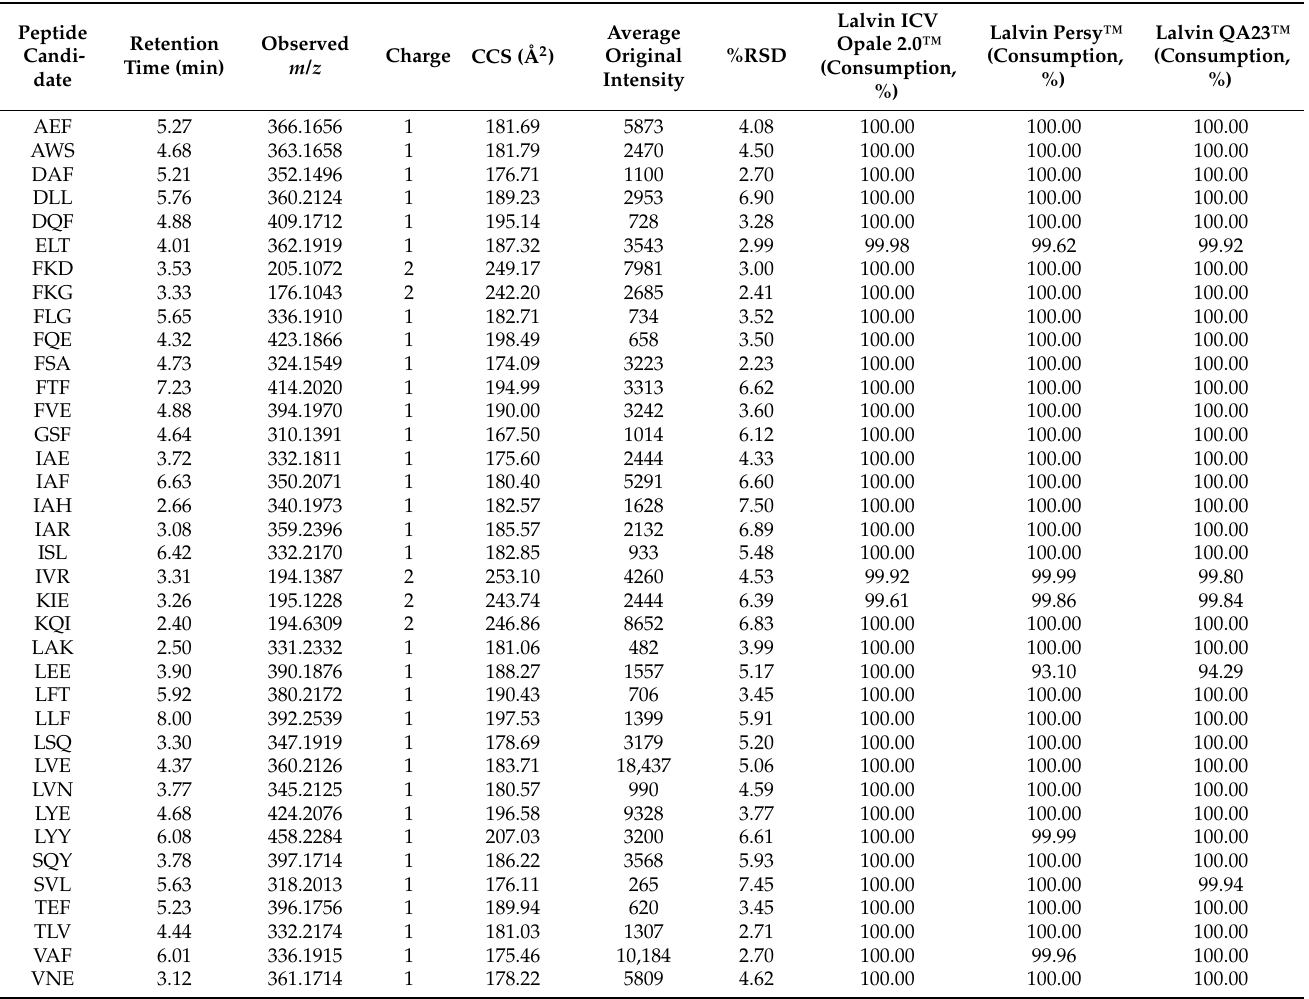
Table A5. The proposed tripeptide sequences and observed relative consumption during fermentation with Lalvin ICV Opale 2.0™, Lalvin Persy™ and Lalvin QA23™ of the modified synthetic must. Peptide sequences were acquired by peptide mapping to bovine serum albumin protein sequence (UniProtKB–P02769 (ALBU_BOVIN)). Additionally presented are the retention time, observed m/z , collision cross section values, as well as the averaged peptide intensities at the starting point and associated relative standard